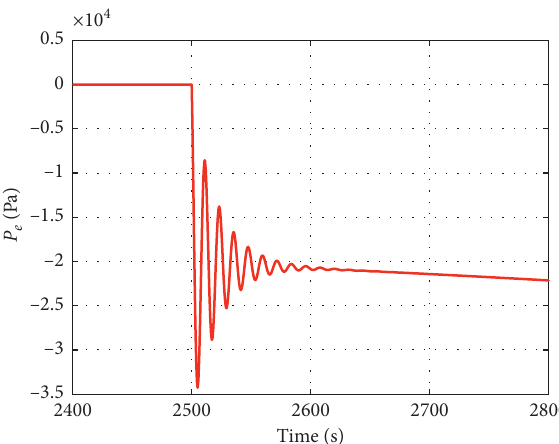
Figure 12: Pressure error caused by the simultaneous double